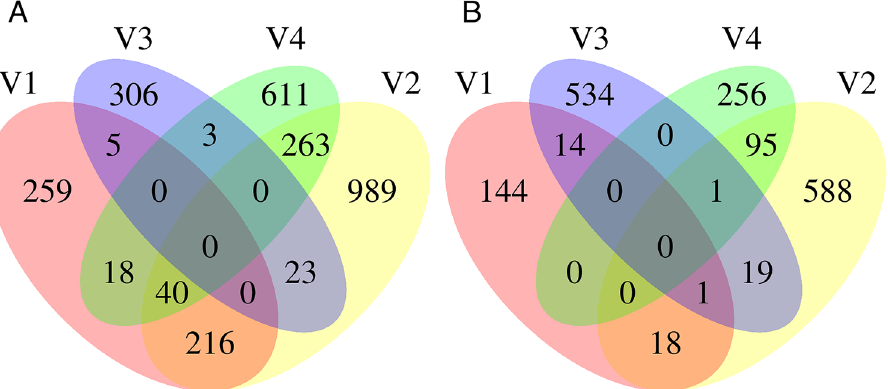
Figure 2. The Venn diagrams show the total number of ( A ) induced and ( B ) repressed genes after FA treatment and the intersection between